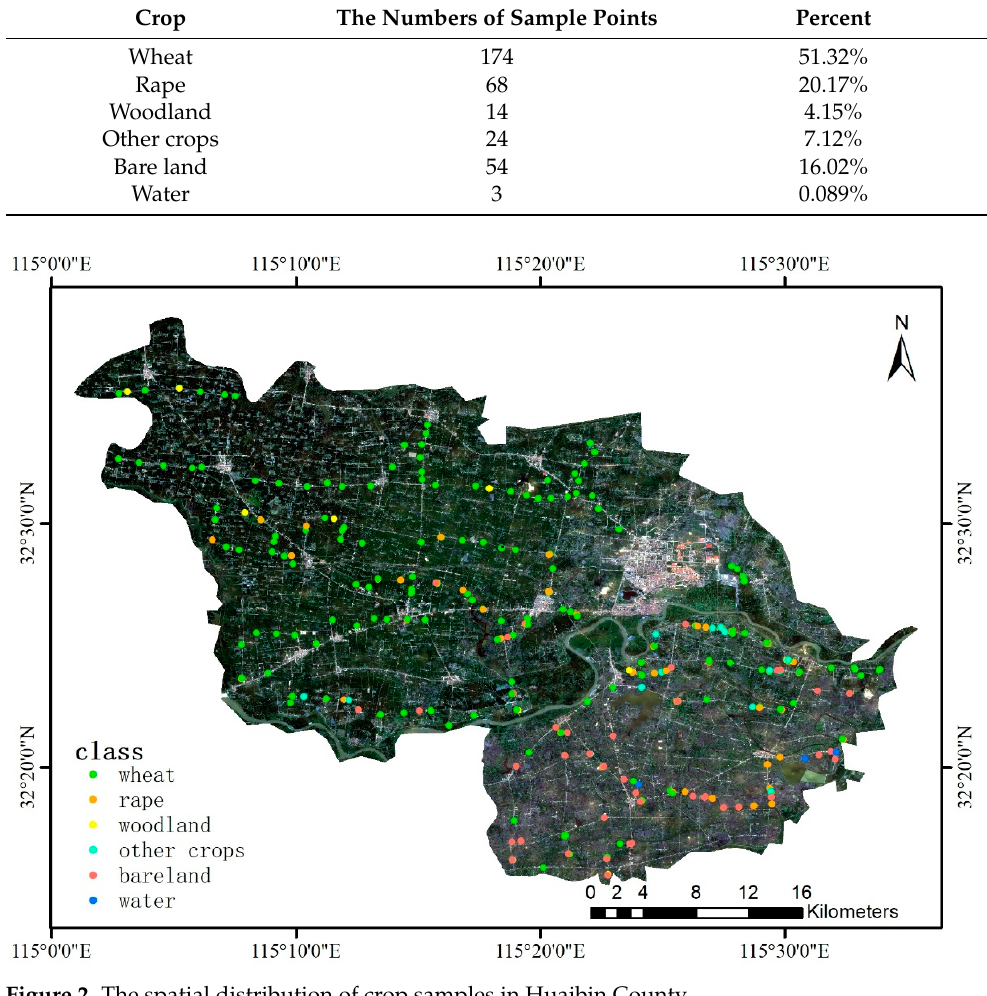
Figure 2. The spatial distribution of crop samples in Huaibin